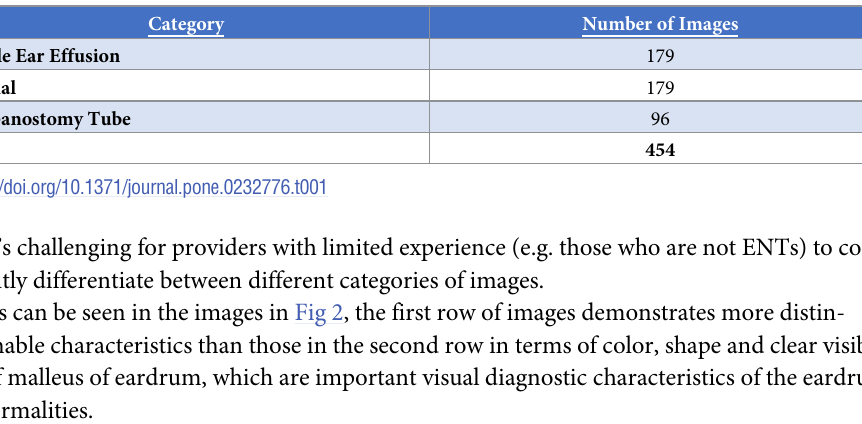
Table 1. Number of images for each class of eardrum types.